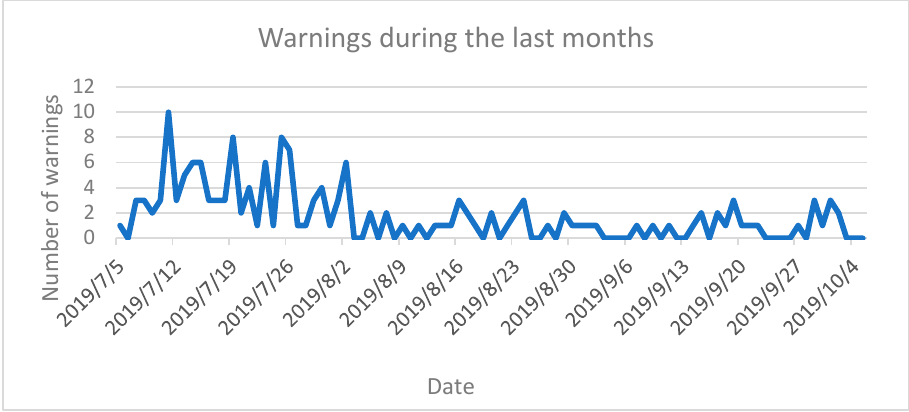
Figure 9. Number of warnings evolution during the last months.